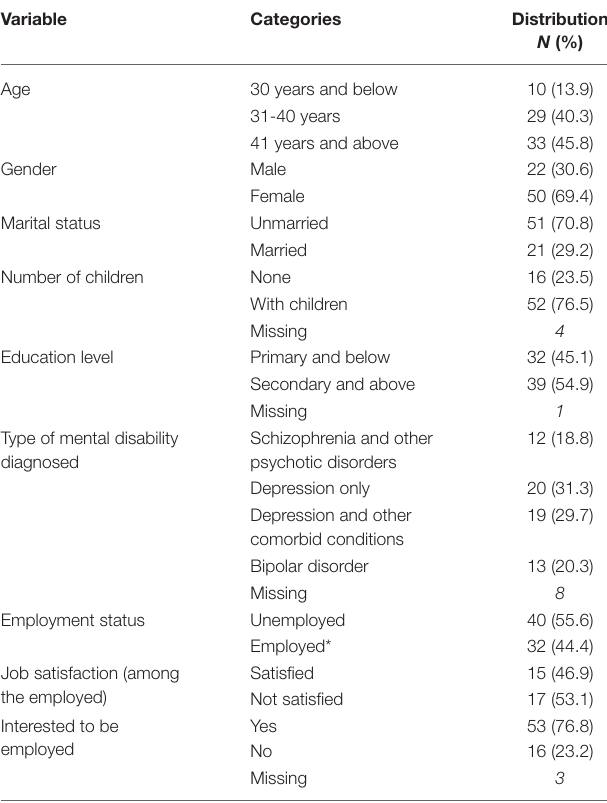
TABLE 1 | Socio-demographic characteristics of the participants ( N =